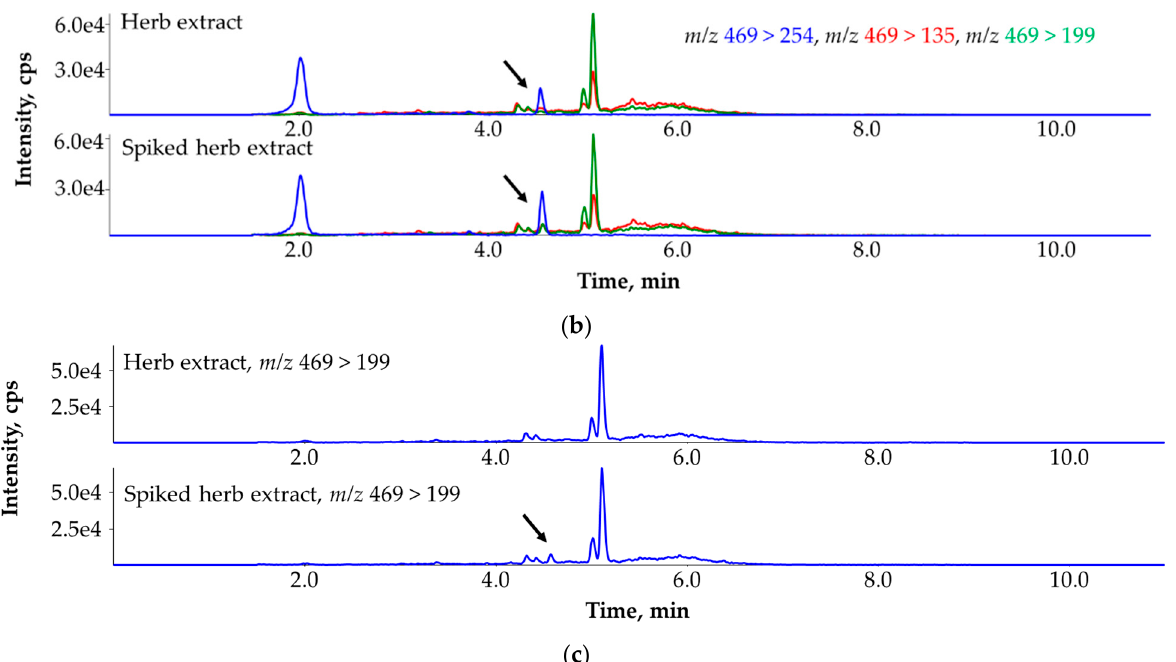
Figure 2. ( a ) Screening analysis of an herb extract. The ion transitions of primisulfuron-methyl in a neat solvent calibrant (100 ng/mL, above) and in the sample (below). ( b ) Confirmatory analysis of an herb extract for primisulfuron-methyl. The ion transitions of m / z 469 > 254 (blue line), m / z 469 > 135 (red line) and m / z 469 > 199 (green line). The spiking level was 0.010 mg/kg. Note the different retention time compared to the screening method, according to Section 2.4. ( c ) Confirmatory analy- sis of an herb extract for primisulfuron-methyl. The ion transition of m / z 469 > 199 was the only selective MRM for primisulfuron-methyl in this sample. The spiking level was 0.010 mg/kg. Differ- ent retention time compared to the screening method can be seen according to Section 2.4.